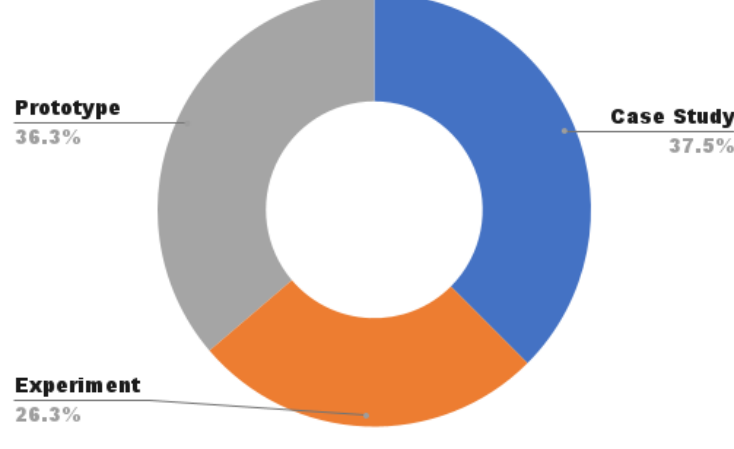
Figure 8. Types of research